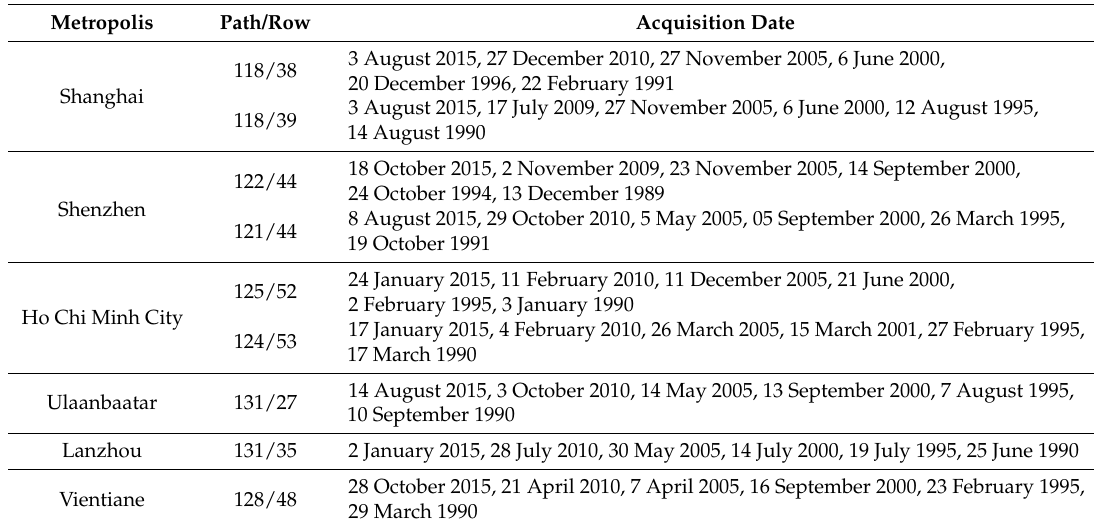
Table 2. Landsat TM/ETM+/OLI data used in this